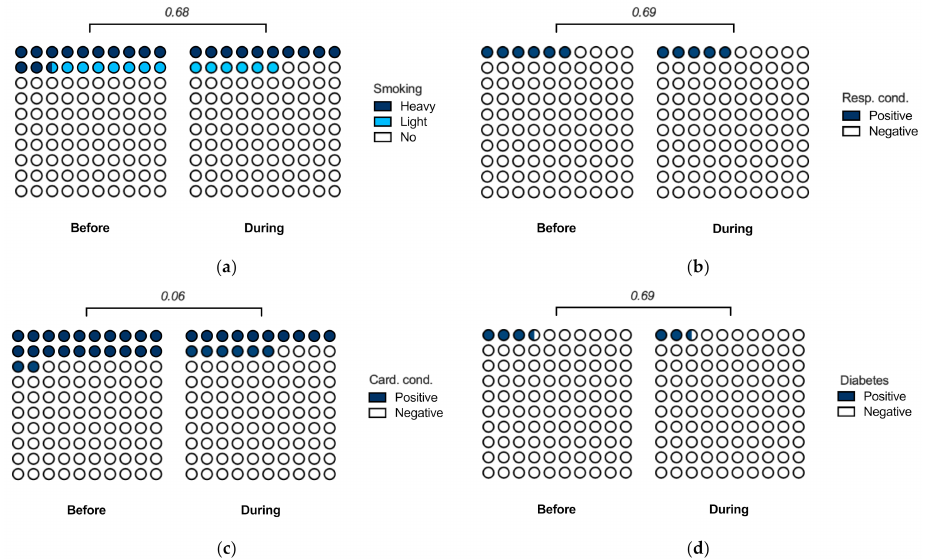
Figure 2. Patient parameters. ( a ) Smoking. Patients were considered light smokers if they smoked fewer than 10 cigarettes per day. ( b ) Respiratory conditions. Positive if patient history included asthma (International Classification of Diseases [ICD] 11 code CA23), chronic obstructive pulmonary disease (CA22), or pulmonary embolism (BB00). ( c ) Cardiovascular conditions. Positive if patient history included hypertension (BA00), hypotension (BA2Z), arrythmia (BC80, BC81), thrombo- sis/thromboembolism (BD71, BD72), or cardiac/vascular transplants/grafts (QB50). ( d ) Diabetes (5A14). All p -values using the Chi-squared test with the Holm–Sidak correction for multiple